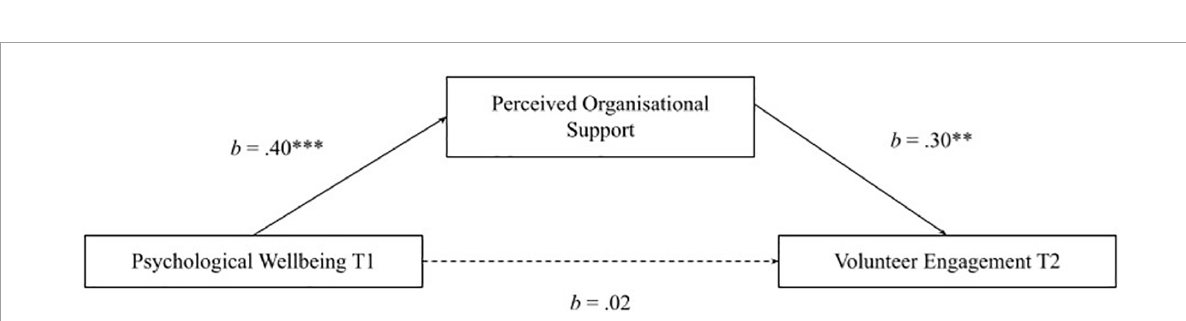
FIGURE5 Full mediation of psychological wellbeing Tl and volunteer engagement T2 through perceived organizational support. Final model of mediation effects measuring young adults’ psychological wellbeing time point 1 (Tl) and volunteer engagement time point 2 (T2) through perceived organizational support, n = 202. Unbroken lines are direct significant pathways between variables; broken lines represent indirect pathways between variables. Unstandardized effects are shown and represented by b values. ∗∗ p < 0.01, ∗∗∗ p <